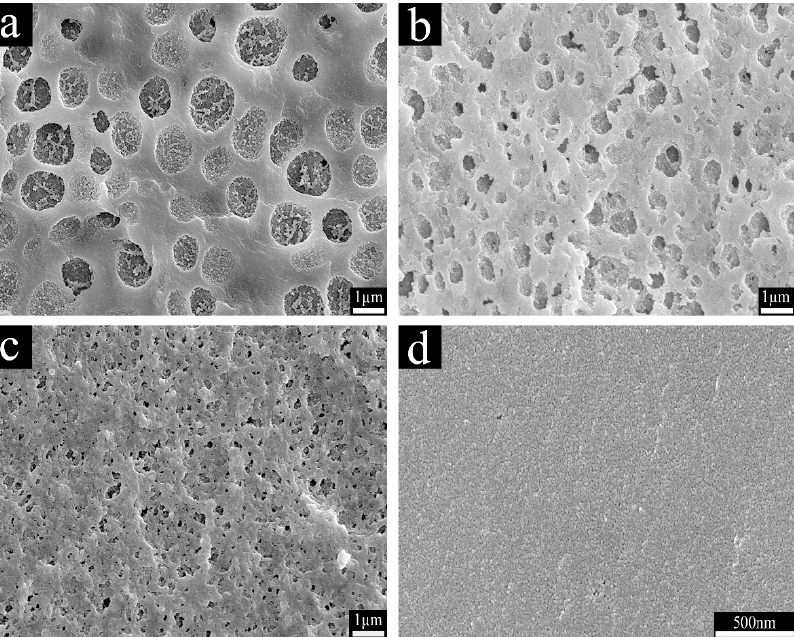
Figure 15. SEM images for the surface of the cured SPF resins after oxidation at 1000 °C for 1.2 h, ( a )